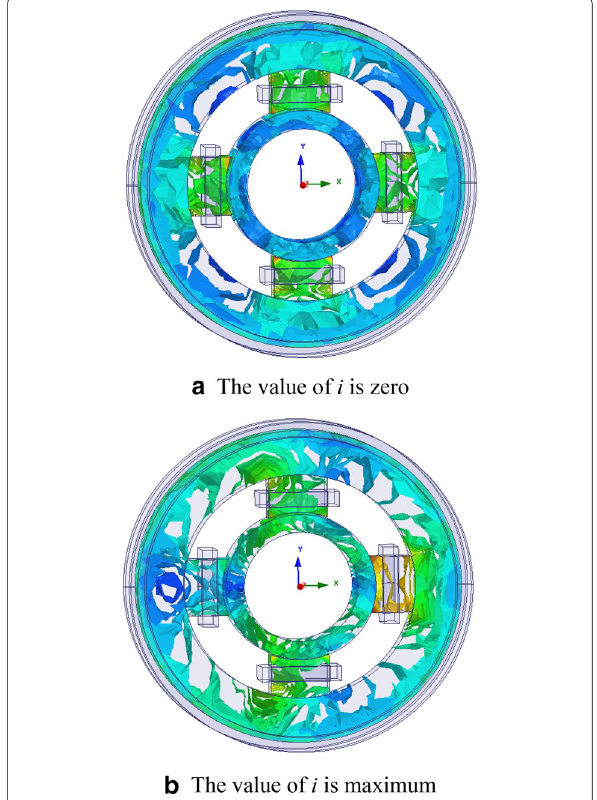
Figure 6 Magnetic flux density distribution of the radial stator and rotor lamination